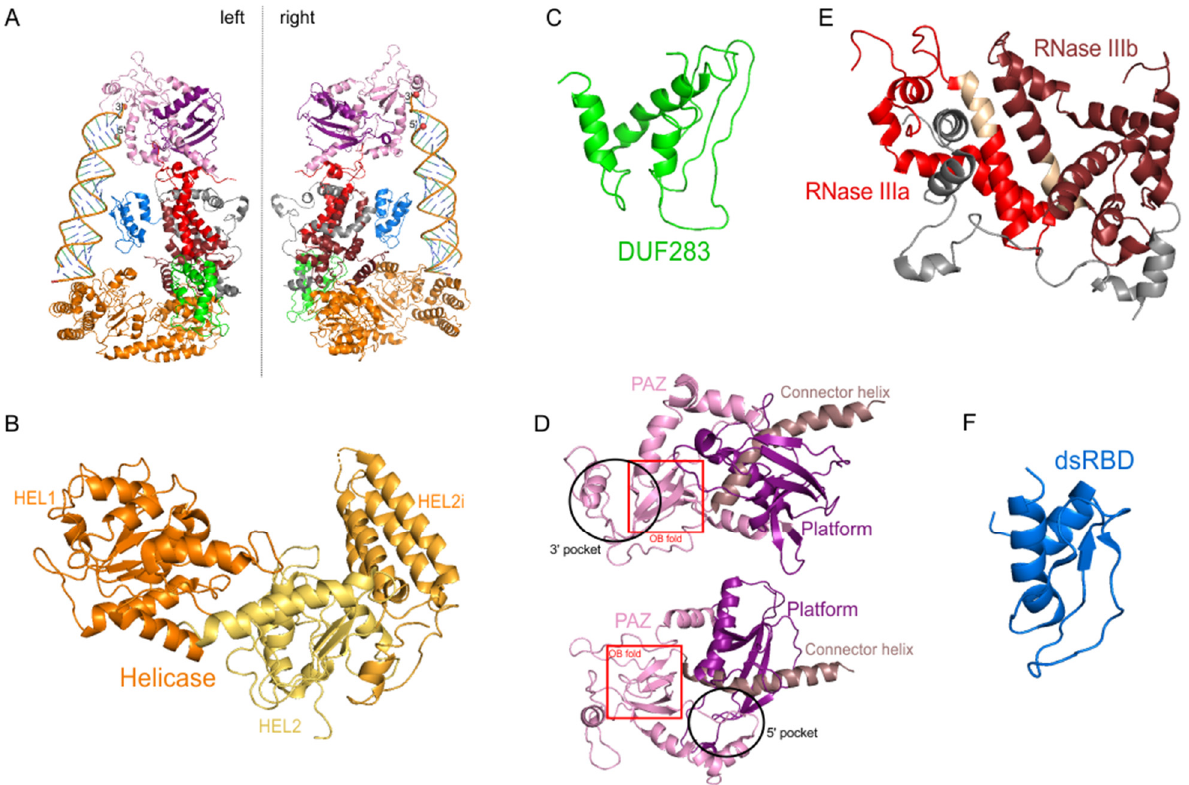
Figure 3. The 3D structure of hDicer (PDB entry 5ZAL) and hDicer individual domains visualized by PyMOL. ( A ) hDicer in complex with pre-let-7 (the loop region is not seen in this structure), the 5 ′ -phosphate and the 3 ′ -hydroxyl are indicated with spheres; ( B ) the helicase domain, with its three internal subdomains, is indicated in orange and yellow; ( C ) the DUF283 domain is indicated in green; ( D ) the Platform–PAZ–Connector helix cassette is shown in two orientations; the upper panel presents the 3 ′ pocket, whereas the lower panel exposes the 5 ′ pocket. The Platform domain is indicated in purple, PAZ in light pink, and Connector helix in brown. The OB fold within the PAZ domain is marked by the red rectangle; ( E ) the catalytic core—RNase IIIa and IIIb domains are indicated in red and wine red, respectively; fragments connecting RNase III domains are indicated in gray; fragments constituting the RNase III signature motifs are colored in beige; ( F ) the dsRBD domain is indicated in blue.